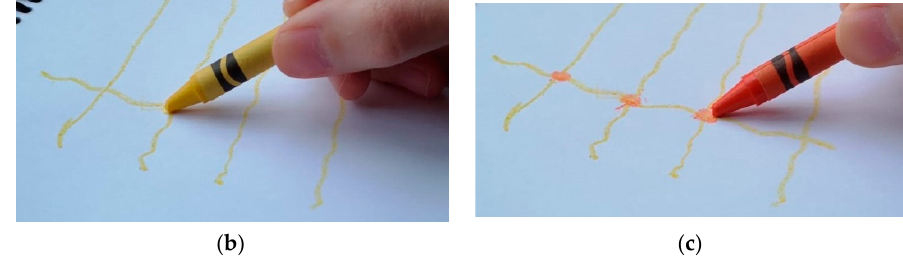
Figure 10. ( a – c ) The three steps of drawing an M-ple. Drawing perpendicular lines would create visual and haptic distinction in students’ experiences due to the orientations of lines. Students most probably start drawing the horizontal lines from the left to the right and vertical lines from the top to the bottom. This spatial and orientational separations might be described by two distinct signs (e.g., “vertical” and “horizontal”; tracing gestures from left to right for horizontal lines and top to bottom for vertical lines) that might be associated with two distinct unit-counts of